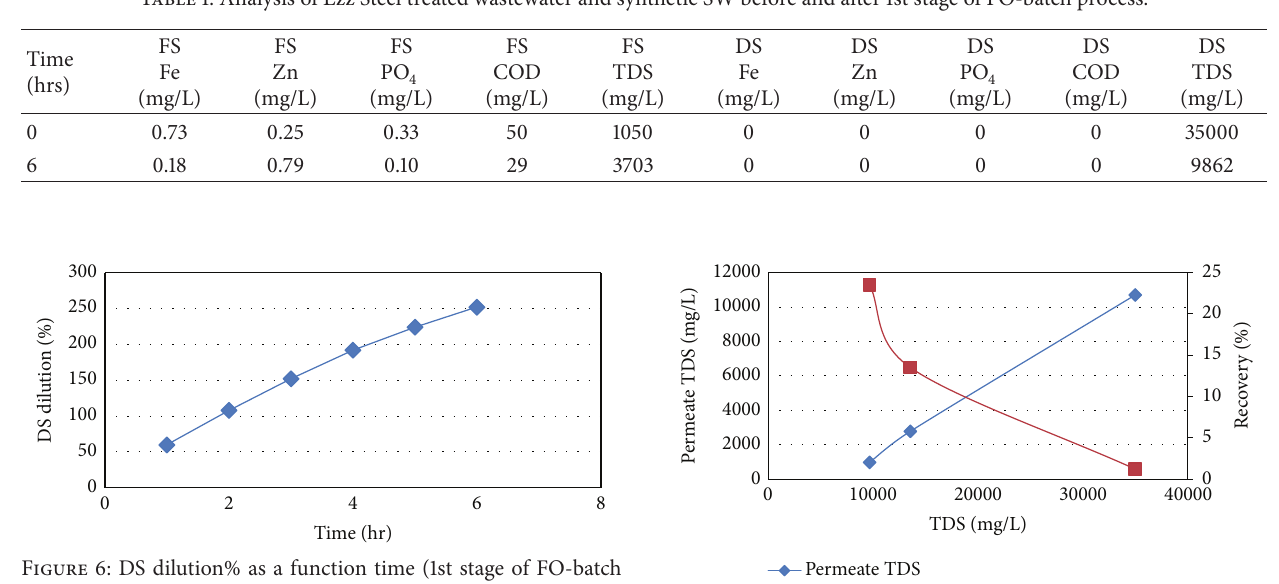
Table 1: Analysis of Ezz Steel treated wastewater and synthetic SW before and after 1st stage of FO-batch process.